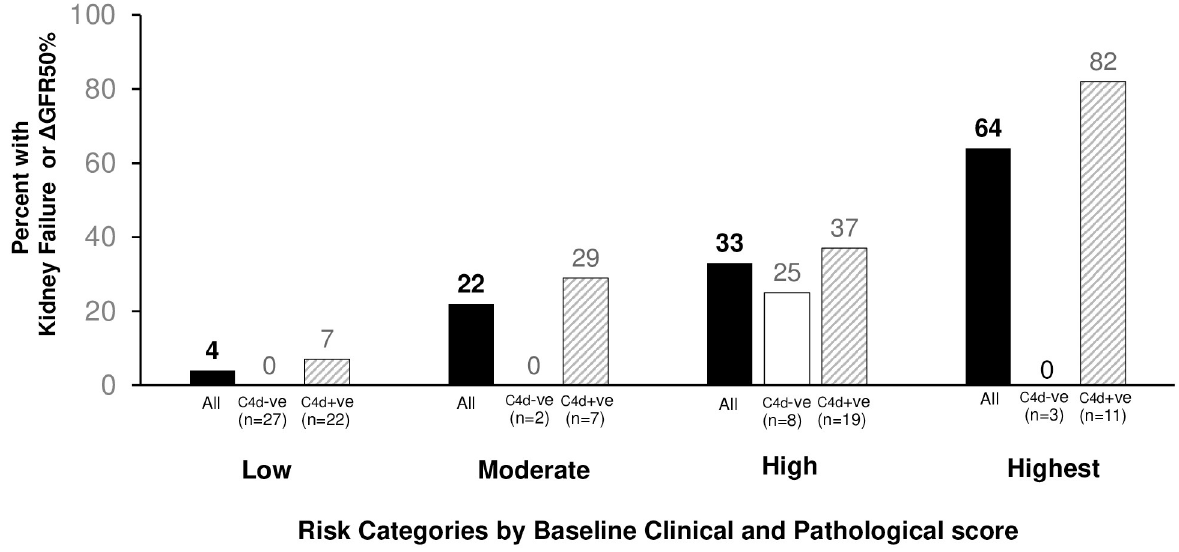
Fig 3. Proportion reaching primary outcome (Kidney Failure or Δ GFR50%) at 5 years according to predicted risk categories and C4d staining. Patients were divided into categories of risk using a model derived from clinical and pathological parameters at baseline: Low (n = 49), Medium (n = 9), High (n = 27), Highest (n = 14). The proportion of patients in each subset reaching primary outcome within 5 years are shown: All in each risk category (black columns); subset in each category stained positive (striped columns) or negative (white column) for